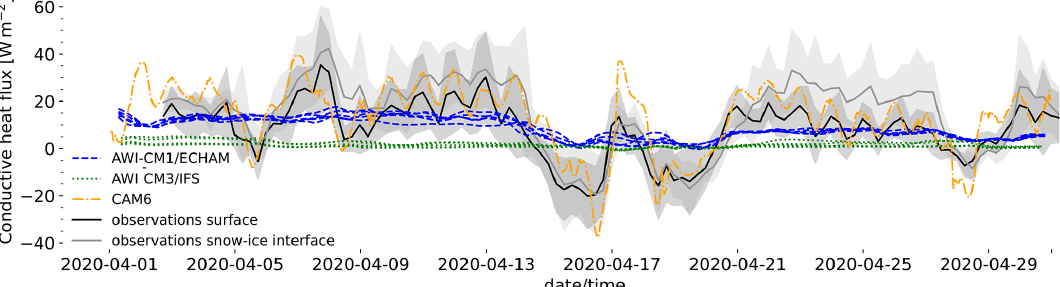
Figure 7. Observed and modelled 6-hourly conductive heat fluxes (positive towards the surface, i.e. upwards) during April 2020. Grey shading shows the range of 1 standard deviation around the mean observational value. Note that measurements are for the uppermost snow layer at the surface and the snow–ice interface, whereas ECHAM data are for conductive heat flux through the ice. For CAM6, the heat flux between the snow surface and the atmosphere was reconstructed from the atmospheric fluxes at the surface.